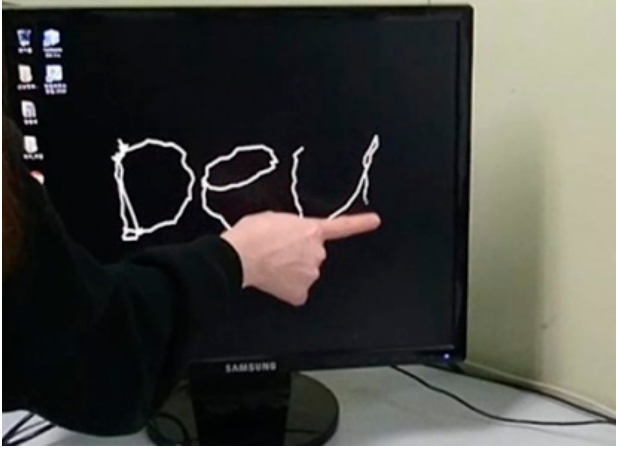
Figure 10. Touch path error.